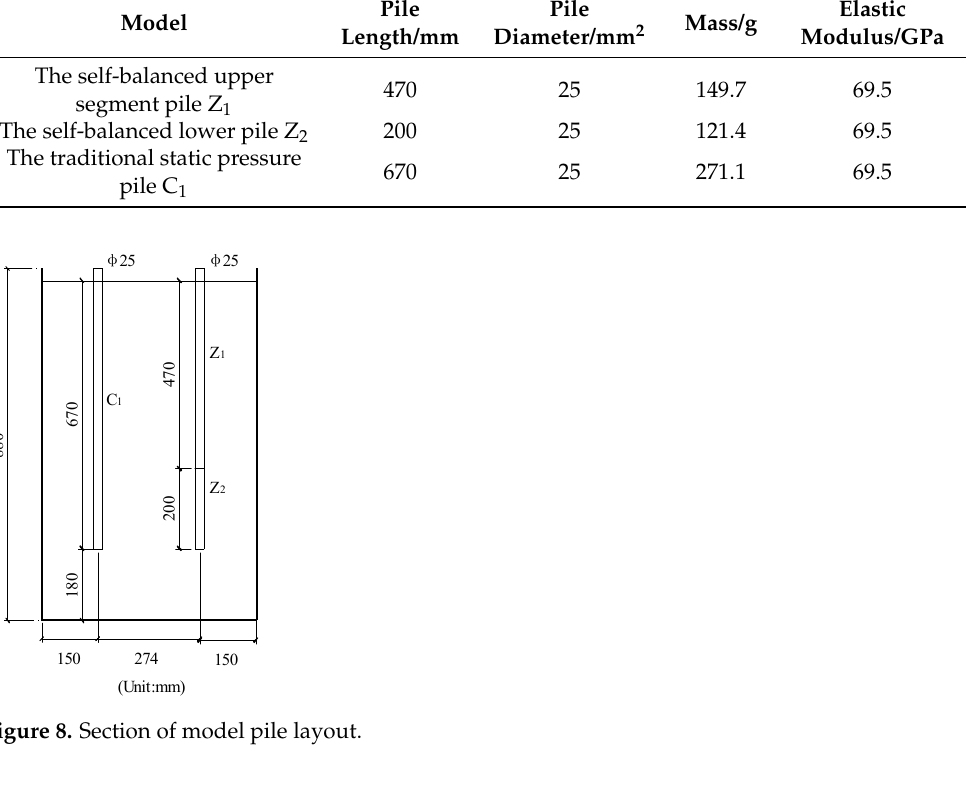
Table 1. Model test pile parameters.